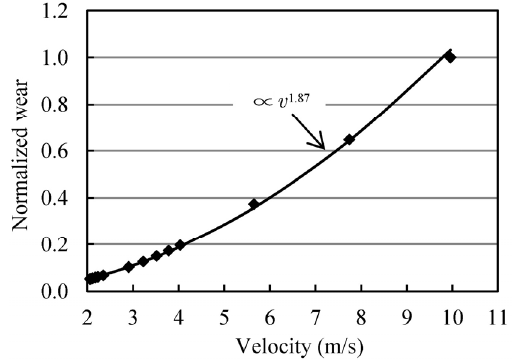
Fig. 5 Variations of the wear versus the particle velocity ( 10  ° and the other variables are at the reference values).